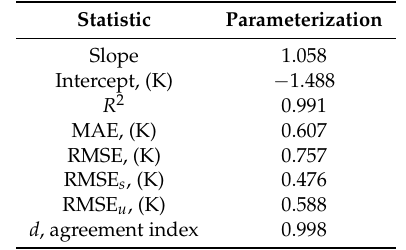
Table 3. Statistical performance of T hem derived using the parameterization scheme relative to modeled T hem,r . MAE is mean absolute error. RMSE s and RMSE u represent the systemic and unsystematic root-mean-square error, respectively. Statistical tests were selected from [29,30]; n =